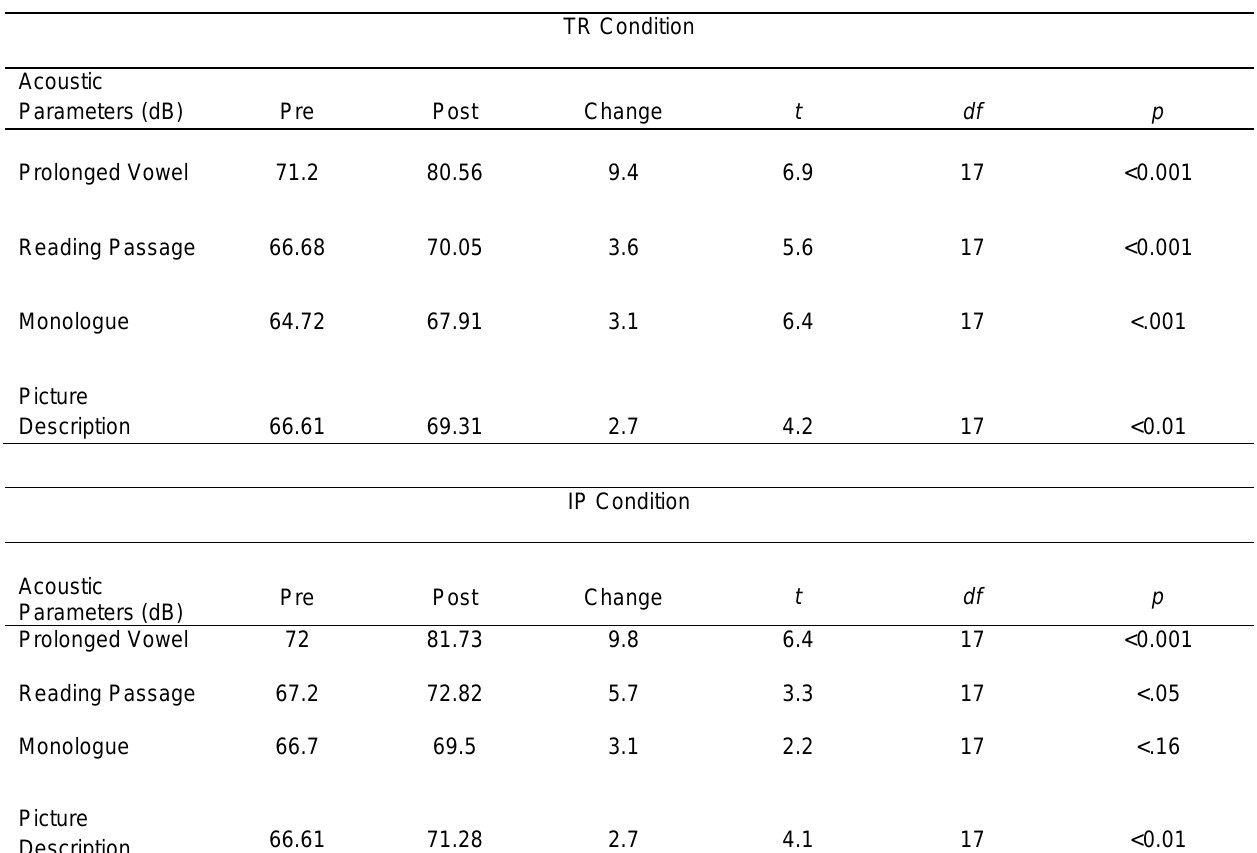
Table 4. Results of